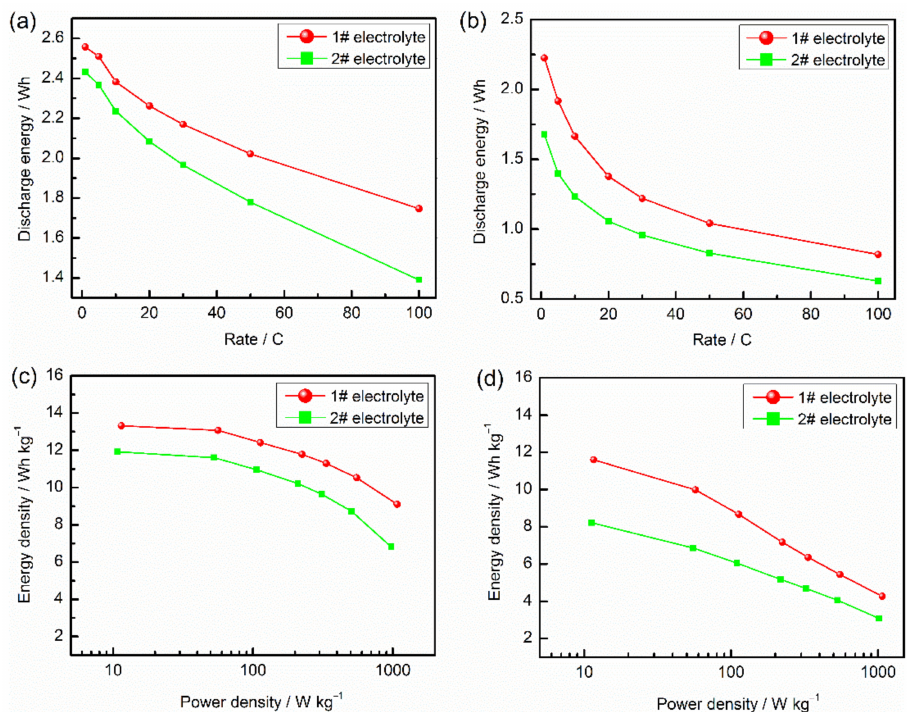
Figure 3. Rate capability of AC/LTO LICs based different electrolytes: ( a ) before cycle; ( b ) after 900 cycles; Ragone plots of AC/LTO LICs based different electrolytes: ( c ) before cycle; ( d ) after 900